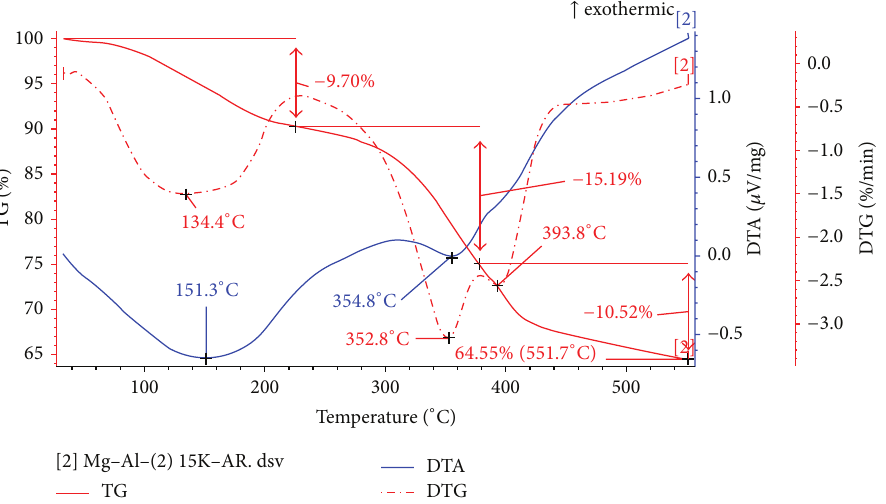
Figure 8: TG-DTA curve of copper-based supramolecular materials.